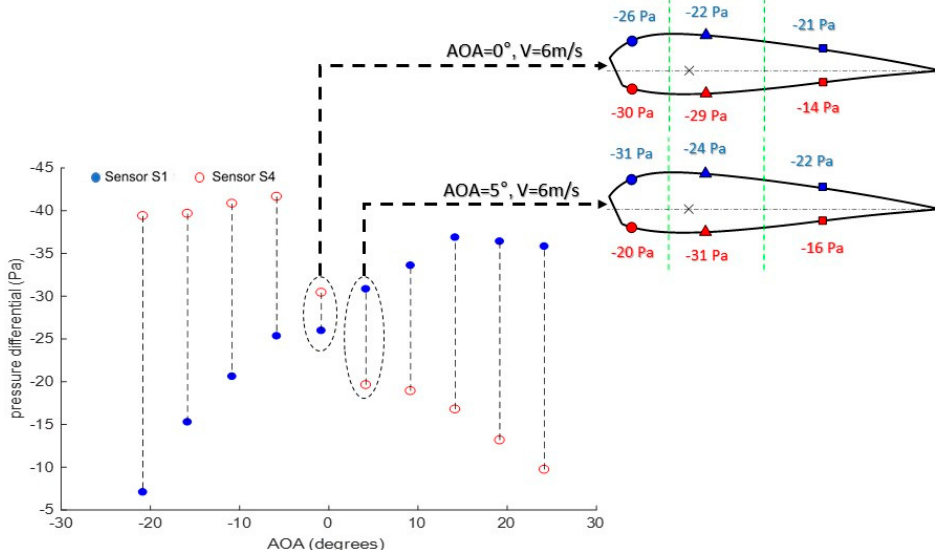
Figure 5. Cell inflation dynamics.